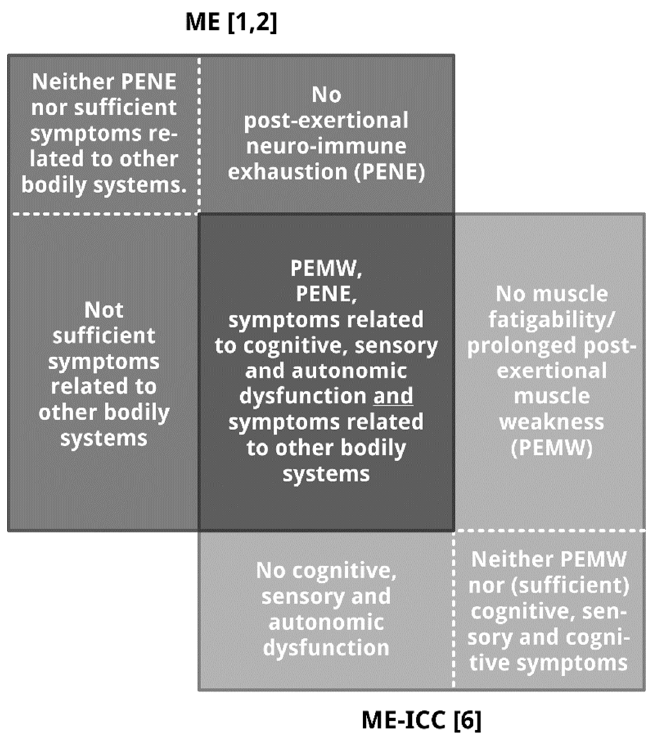
Figure 1. Overlap and differences between the case criteria of ME [1,2] and ME-ICC [6]. Note: Surface size does not reflect proportion. The (relative) number of patients in the seven subpopulations, especially the number of patients meeting the diagnosis of ME [1,2] and ME-ICC [6], and the patient subpopulation in the center are yet unknown. Figure 1 illustrates seven relevant patient subpopulations: patients meeting the diagnostic criteria of both ME and ME-ICC (the darkest grey rectangle in the centre), three ME patients subgroups not meeting the diagnosis ME-ICC (dark grey rectangles), and three groups of patients fulfilling the diagnostic criteria of ME-ICC, but not meeting the diagnosis ME (light grey rectangles).